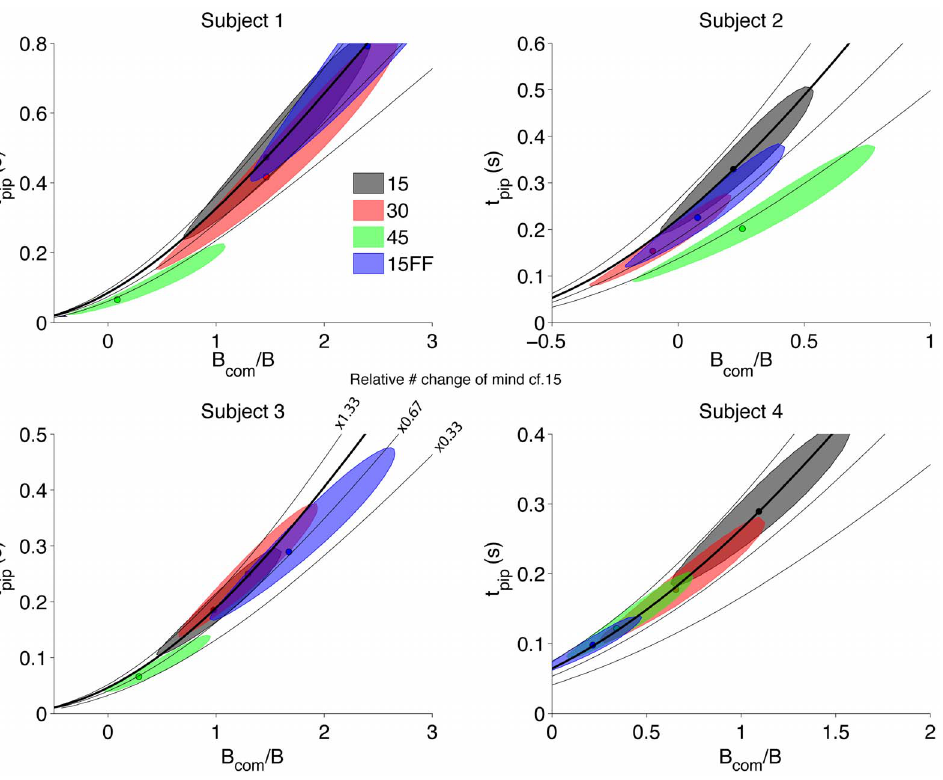
Figure 8. Parameter fits to the change of mind model for each subject. The change of mind model fits the change of mind bound B com and the time allowed for post-initiation processing t pip . For each condition, the maximum likelihood estimates (small solid circles) are shown, as well as the 95% confidence region for the parameter estimate (shaded region). The proportion of change-of-mind isocontour lines are shown for the proportion of change of mind trials in the 15 u target separation condition (solid line) as well as for proportion of change of mind trials that are 33, 67 and 133% that of the 15 u separation condition.